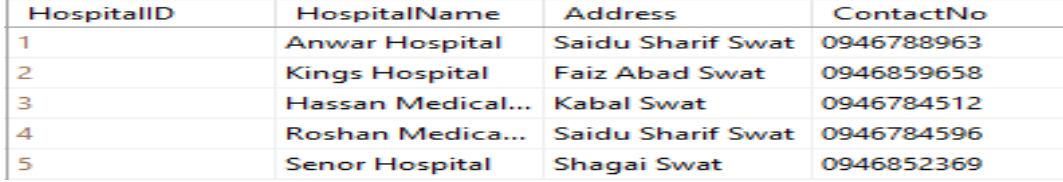
Figure 4. Hospitals